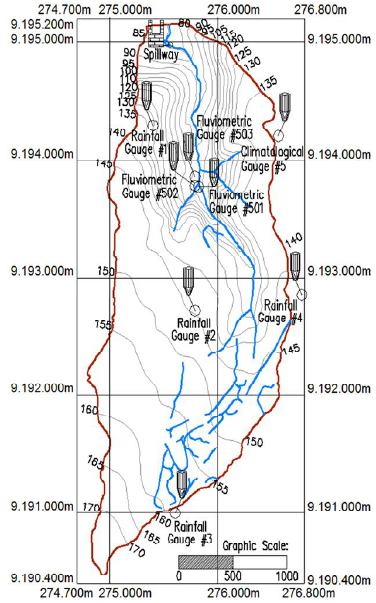
Figure 3. Guaraíra experimental watershed - Monitoring